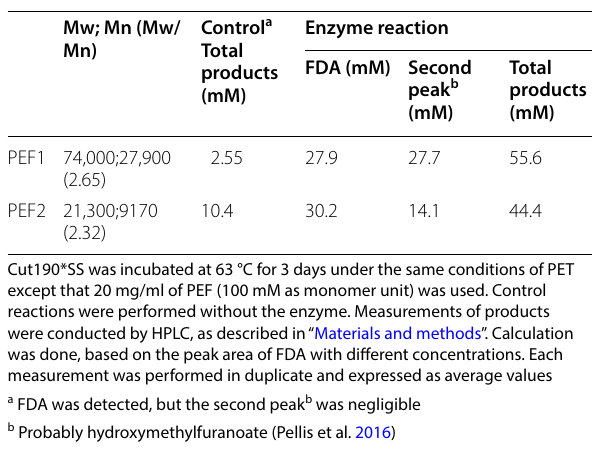
Table 5 Hydrolysis of PEF by Cut190 variant